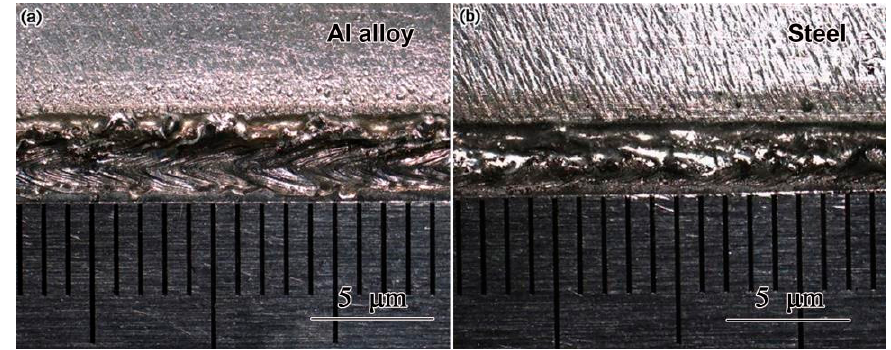
Figure 3. Weld appearance of Al/steel butt joints produced by autogenous laser keyhole welding: ( a ) top surface; ( b ) bottom surface.